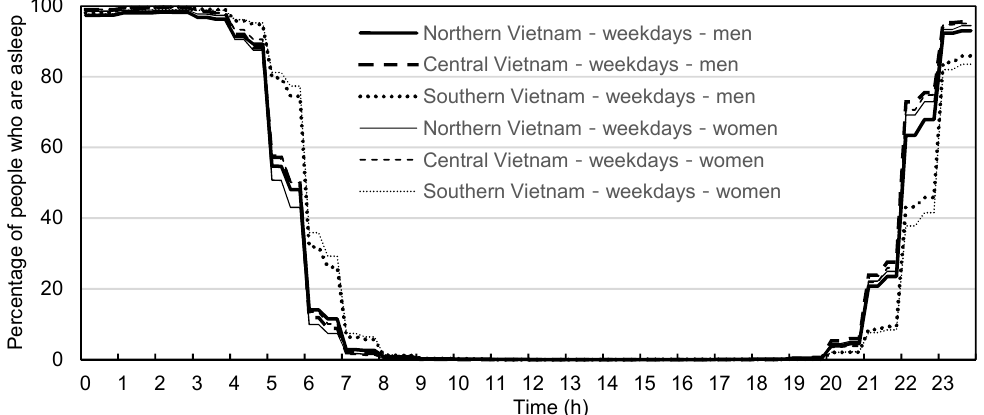
Figure 5. Sex di ff erences in Vietnamese people’s sleeping temporal pattern by region (northern, central, Figure 5. Sex differences in Vietnamese people’s sleeping temporal pattern by region (northern, and southern Vietnam) on central, and southern Vietnam) on weekdays.